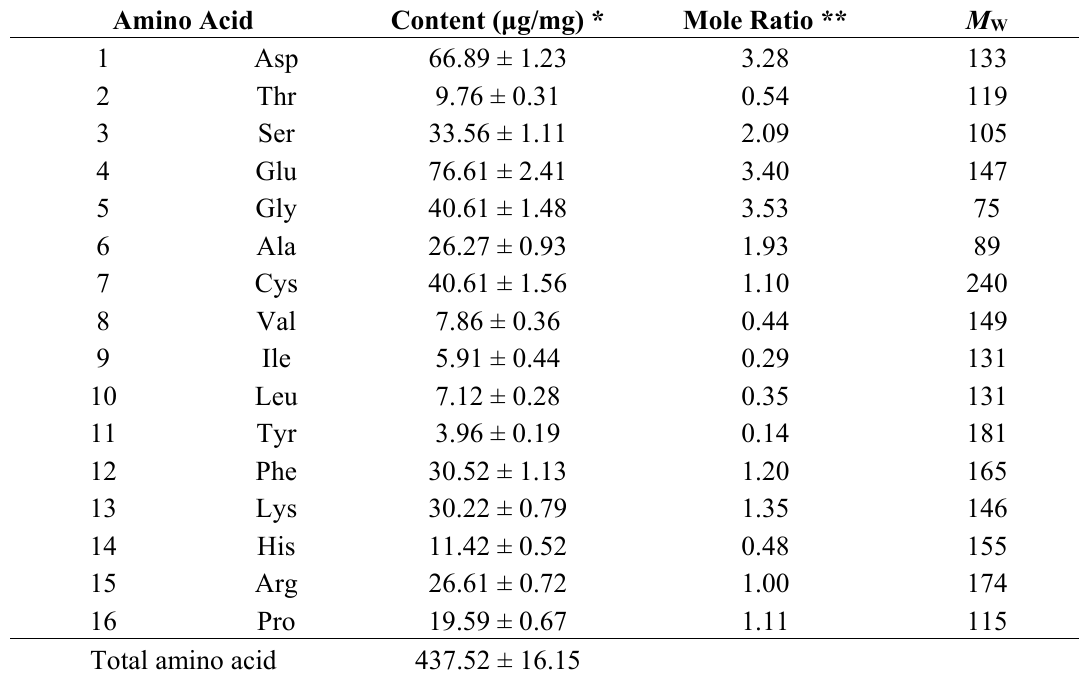
Table 2. Amino acid composition of